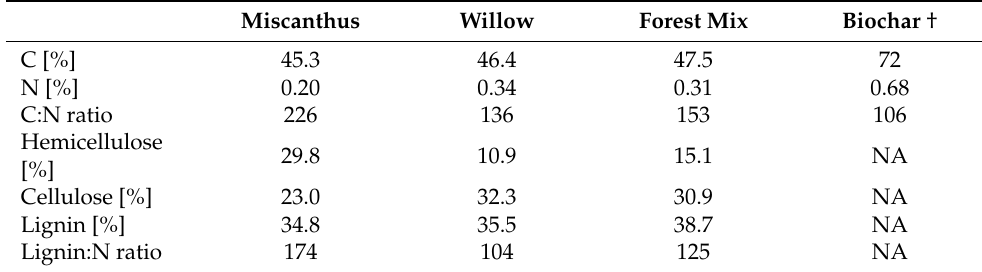
Table 2. Amendment properties (dry weight basis).